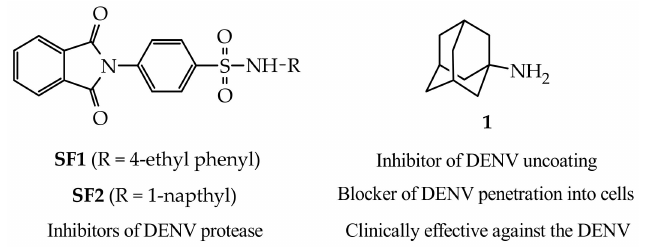
Figure 3. Benzsulfonamide derivatives ( SF1 and SF2 ) as DENV2 NS2B/NS3 protease inhibitors and the structure of the anti-DENV agent, amantadine ( 1